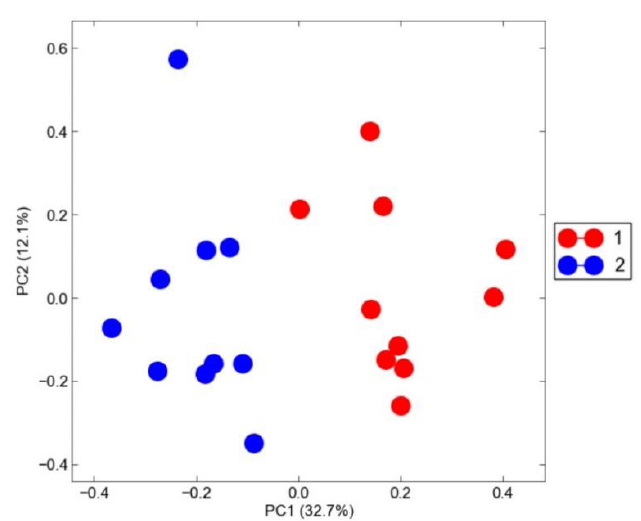
Figure 1. Plot of principal component analysis. Relative abundance log folds accounting for the total raw count are shown. Red point: class I (first plus grade), blue point: class II (second grade).